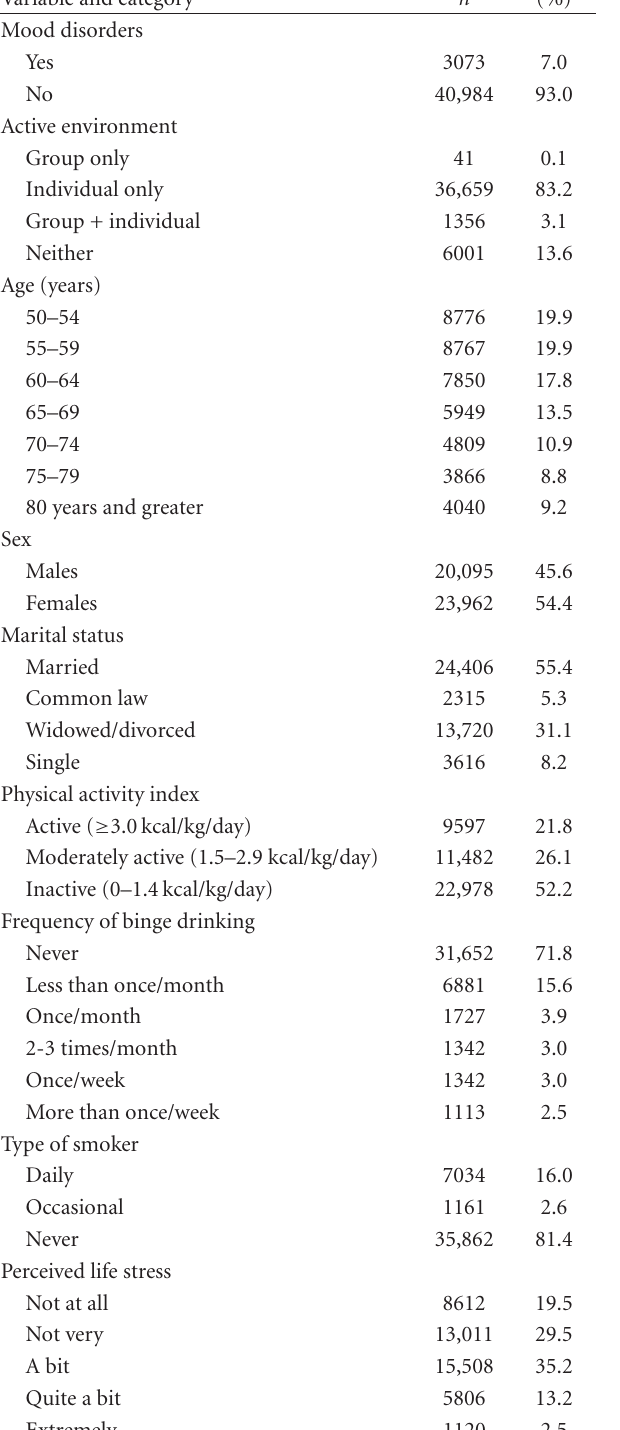
Table 1: Sample descriptive statistics for all variables in the analyses ( N = 44,057).